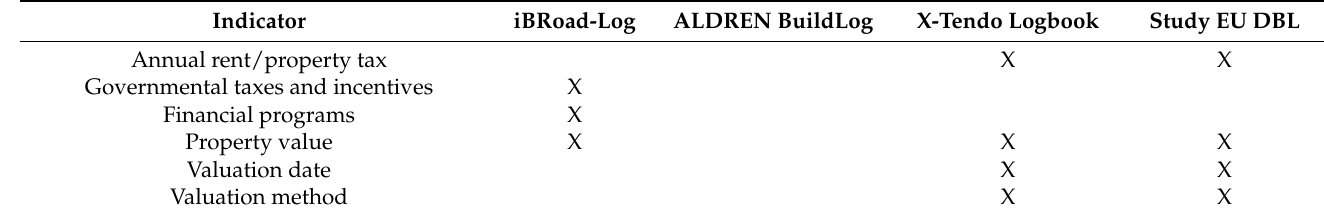
Table A5. Module 5: economic and financial